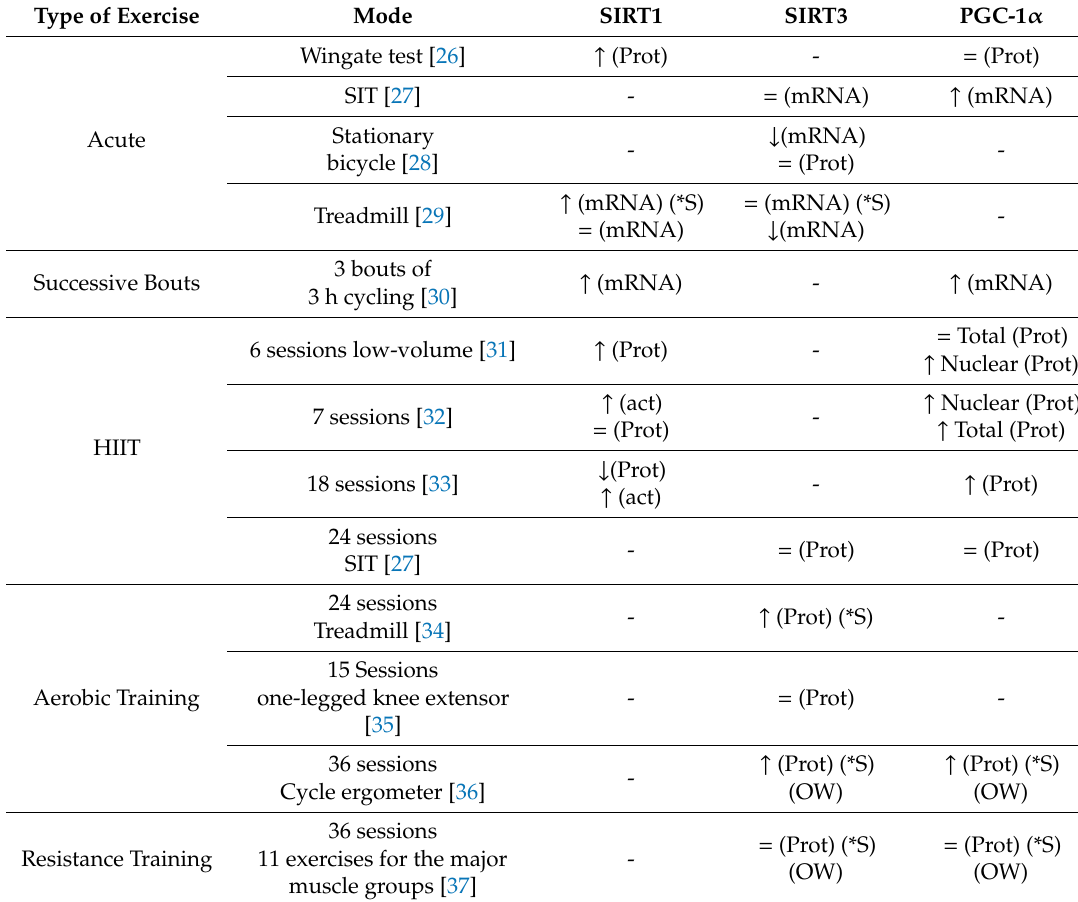
Table 1. E ff ects of di ff erent types of exercise on SIRT1, SIRT3 and PGC-1 α